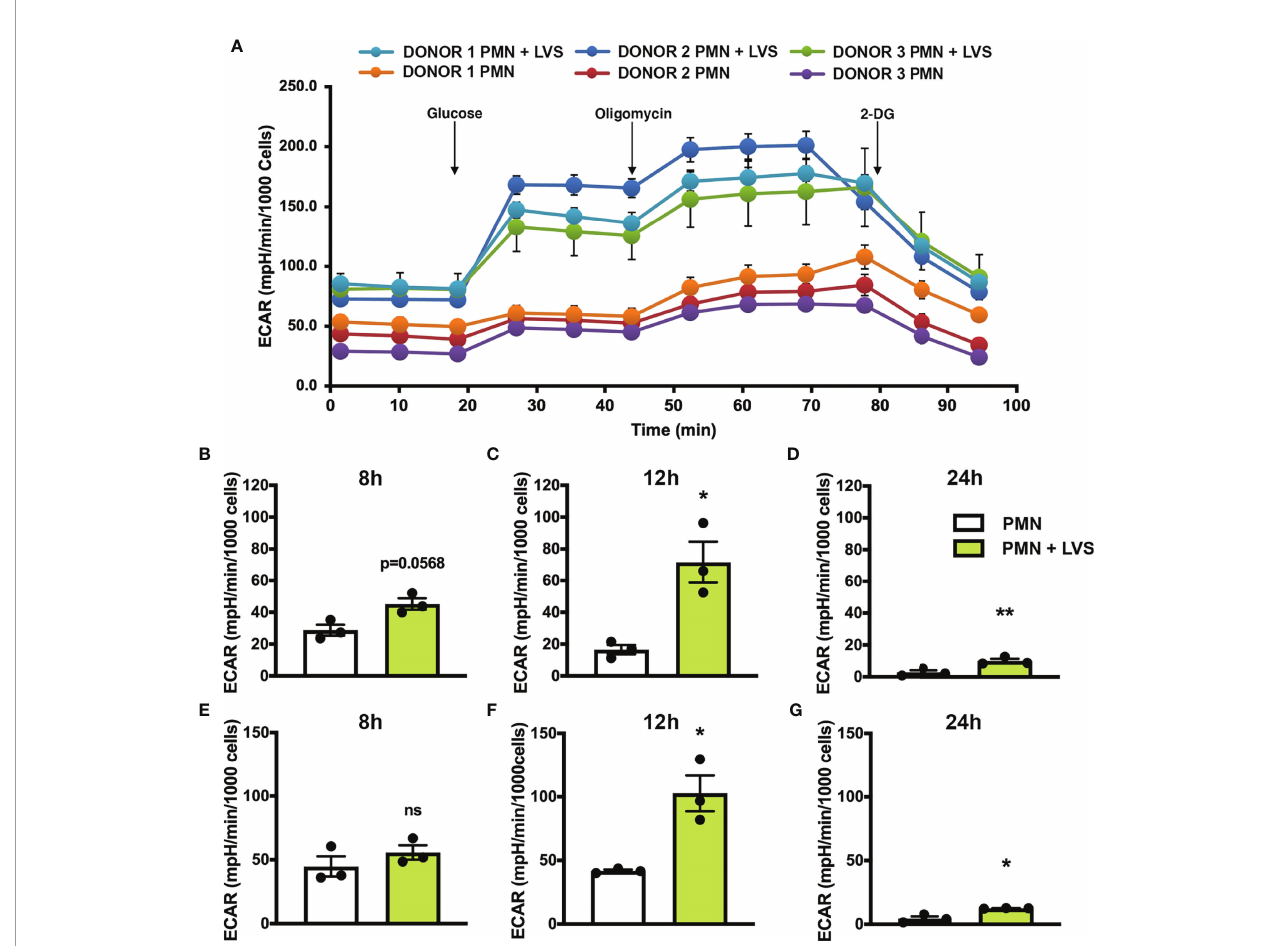
FIGURE 2 | LVS infection upregulates PMN glycolysis. Glycolytic function measured by Seahorse analysis as extracellular acidi fi cation rate (ECAR) in control and LVS-infected PMNs, n=3. (A) ECAR curves at 12 hr. Glucose was injected to a fi nal concentration of 10 mM at 20.84 min, oligomycin was injected to a fi nal concentration of 1 µM at 46.78 min and 2-DG was injected to a fi nal concentration of 50 mM at 72.83 min. Where not visible, error bars are smaller than symbols. Quantitation of glycolysis (B – D) and glycolytic capacity (E – G) in control and LVS-infected PMNs at 8, 12 and 24 hpi. * p < 0.05. ** p < 0.01. ns, not signi fi